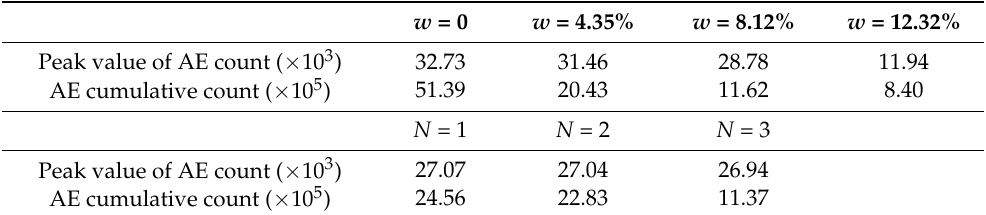
Table 2. Statistical table of acoustic emission peak count and cumulative count of coal samples in different water states.